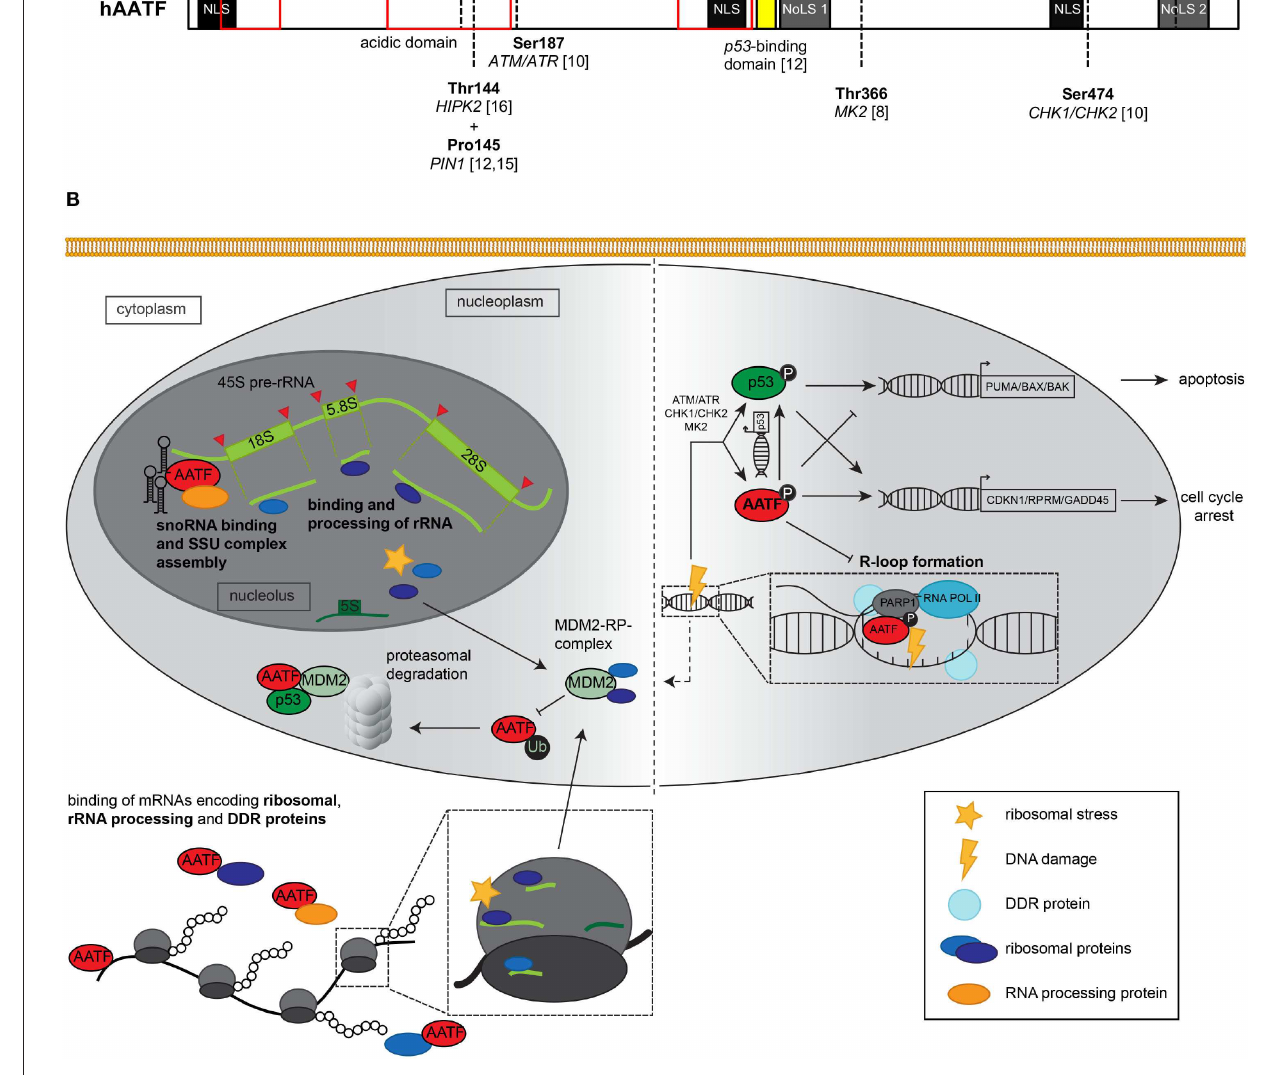
FIGURE 1 | (A) Schematic representation of the AATF/Che-1 protein structure. The 560 amino acids containing protein consists of three nuclear localization sites (NLS), two nucleolar localization sites (NoLS, dark gray) two N-terminal acidic domains (red), and a leucin zipper as classical DNA binding domain (red). Multiple serine and tyrosine residues may be phosphorylated by kinases such as CHK1/CHK2, ATM/ATR as well as MK2 and HIPK2 (8, 10, 11); in addition, proline 145 is isomerized by prolyl isomerase 1 (PIN1) (12, 13). The C-terminal part of the protein displays great homology to the murine homolog Aatf/Traube and is therefore known as AATF/Che-1/Traube superfamily domain. AA 305–323 (yellow) have been shown to be essential for the interaction of AATF with p53 protein (12). (B) Graphical summary of nucleolar, nucleoplasmic, and cytoplasmic functions exerted by AATF and its response to ribosomal stress and DNA damage. Left panel: Nucleolar AATF is involved in binding and processing of ribosomal RNA, e.g., through binding of both 45S pre-rRNA (light green) and snoRNA (black hairpins) along with other RNA binding proteins that may process rRNA. In the nucleus and cytoplasm, AATF binds to mRNA encoding ribosomal proteins, rRNA processing enzymes as well as proteins involved in the DDR, which may the respective proteins’ expression levels. Upon ribosomal stress, RPs (dark blue, purple) from the nucleolus as well as RPs from disassembled ribosomes shuttle to the nucleoplasm, where they may interact with E3 ubiquitin ligase MDM2. MDM2 is able to ubiquitinate AATF after isomerization by PIN1 (not shown), which subsequently leads to proteasomal degradation of AATF. In addition, AATF directly binds both p53 and MDM2 protein. Right panel: Upon DNA damage, canonical DDR kinases such as ATM/ATR, CHK1/CHK2, and MK2 phosphorylate and thereby active AATF [(for specific phosphorylation sites, see panel (A) ], which in turn impacts on p53 transcriptional activity and may itself transactivate anti-apoptotic genes such as CDKN1 or RPRM. In addition, AATF relocates to sites of DNA damage, where it interacts with DNA repair protein PARP1 and may play a role in DNA repair. Recently, AATF was shown to inhibit R-loop formation, while knockdown of AATF led to increased frequency of R-loops and DNA damage. Excessive genotoxic stress may also activate MDM2 (dashed arrow), leading to proteasomal decay of AATF and transactivation of pro-apoptotic genes by p53. ATM, Ataxia Telangiectasia Mutated serine-protein kinase;